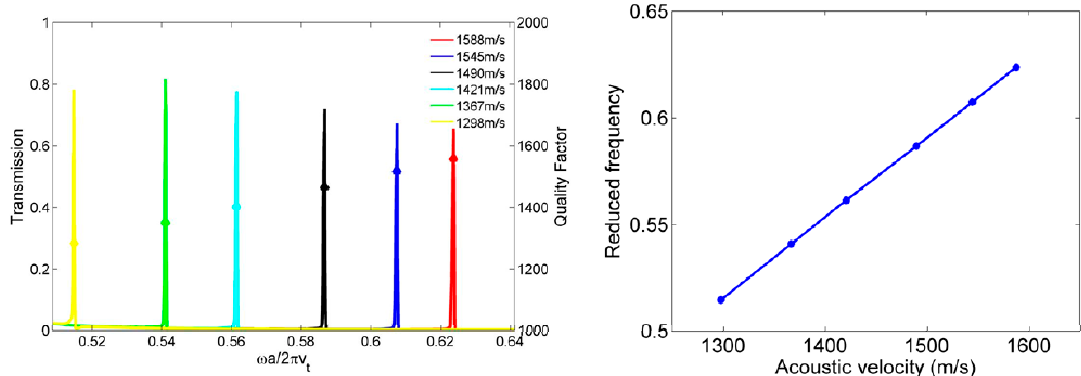
Figure 8. ( Left panel ): Evolution of the second liquid compressional mode induced transmission peak (lines, corresponding to the left y -axis) and quality factor (dots, corresponding to the right y -axis) as a function of the acoustic velocity of filled liquid. The geometric parameters are h/a = 0.4, r/a = 0.39, r i /a = 0.1, h liq /h = 1, l/a = 0.1. ( Right panel ): The frequency of transmission peak corresponds to the acoustic velocity of different fluids.